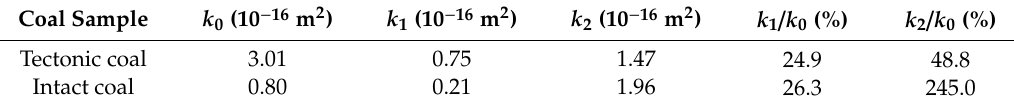
Figure 4. Stress-permeability-time curves of coal under triaxial compression. ( a ) tectonic coal and ( b ) intact coal. Table 4. Critical permeabilities of tectonic and intact coal during each